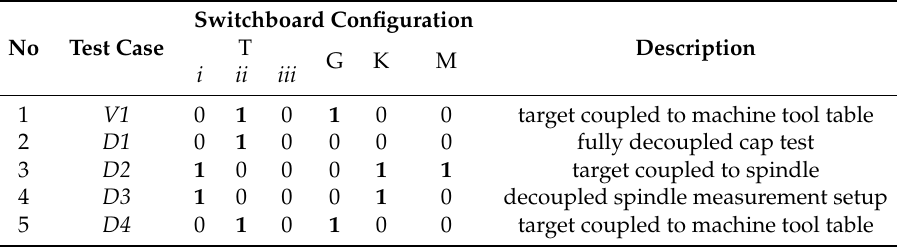
Table 3. Exemplary testing device configurations according to Figure 7a.